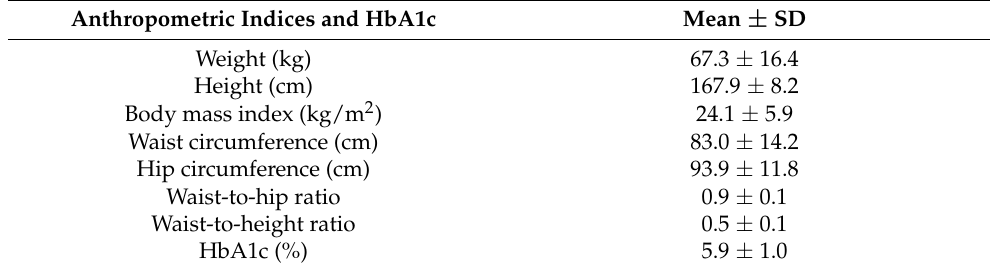
Table 2. The physiological characteristics of South African males aged 20 years and